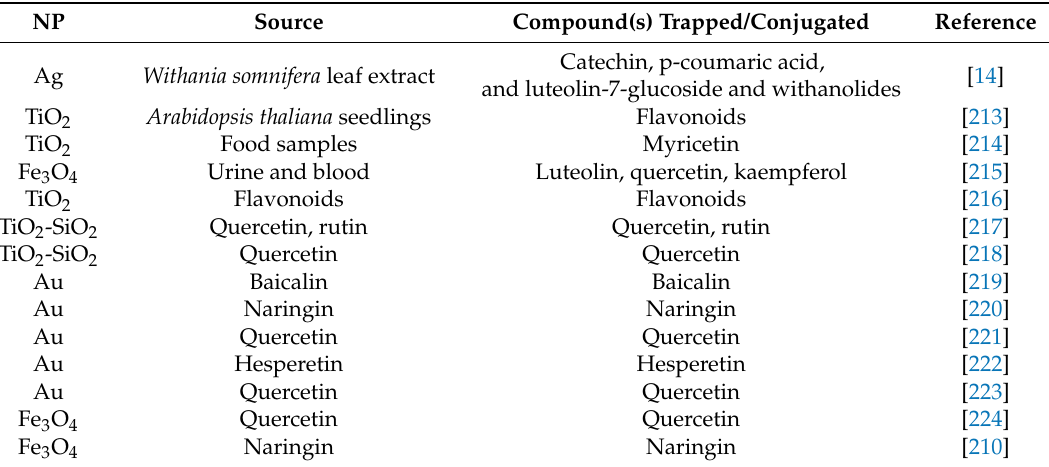
Table 3. Secondary metabolites conjugated with